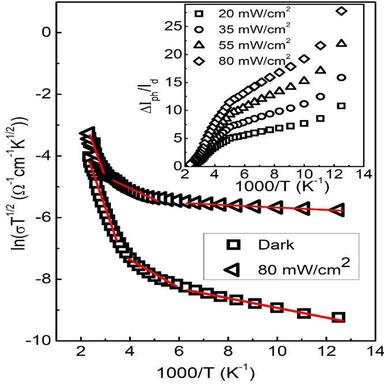
Activation energy analysis on conductivity profile under dark and illumination conditions. Inset shows photosensitivity of the CZSe thin film under the illumination intensity of 20, 35, 55 and 80 mW/cm2 .